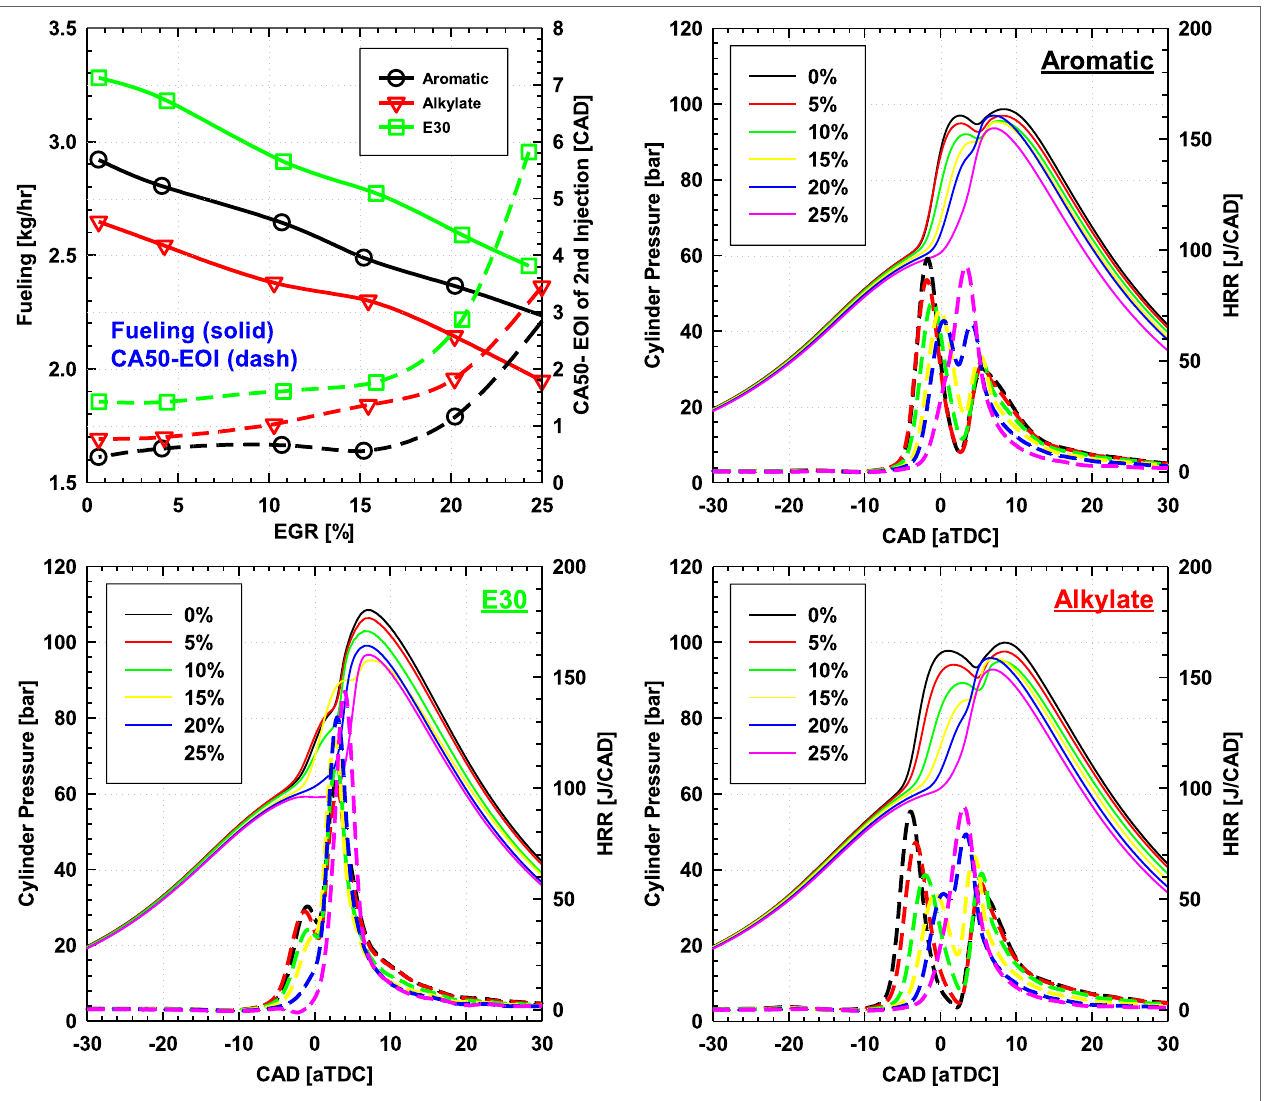
FigUre 3 | Exhaust gas recirculating (EGR) sweep (0–25%) results with start of injection adjustment of second injection for constant combustion phasing: fuel mass flow rate and combustion delay (top left) and cylinder pressure and heat release of each fuels (aromatic, alkylate, and